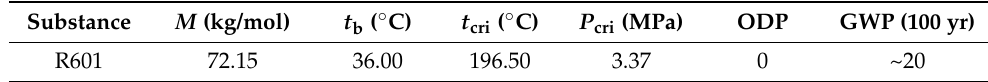
Table 4. The thermophysical properties of R601 [52].